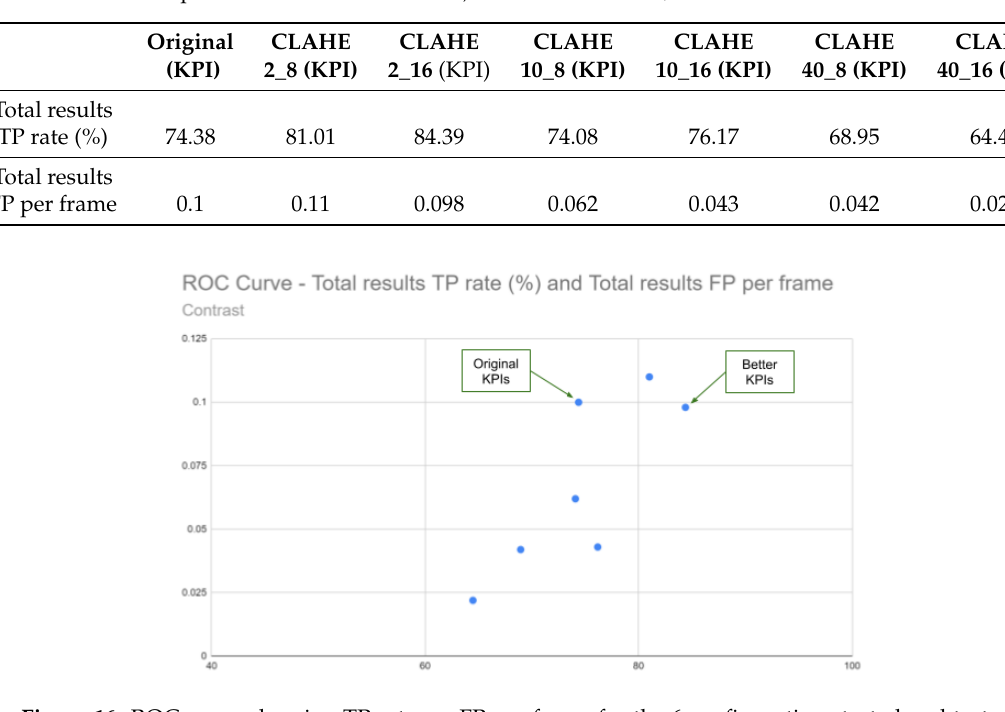
Figure 16. ROC curve showing TP rate vs. FP per frame for the 6 configurations tested and test on original